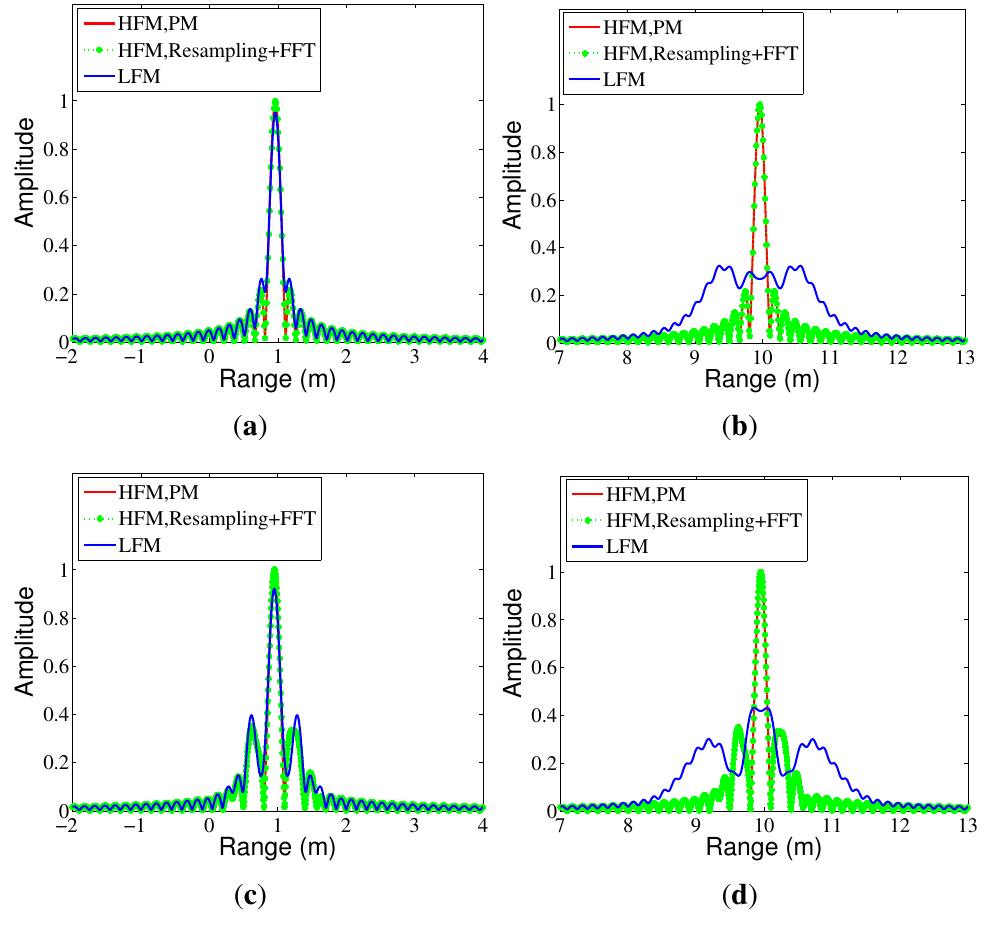
Figure 5. The high resolution range profile (HRRP) of a single point target. ( a ) Ideal waveform, υ = 100 m/s; ( b ) ideal waveform, υ = 1000 m/s; ( c ) with frequency errors, υ = 100 m/s; ( d ) with frequency errors, υ = 1000 m/s. Table 1. Peak sidelobe ratio (PSLR) and integrated sidelobe ratio (ISLR) with different velocities. Ideal Waveform With Frequency Errors Waveform Velocity (m/s) PSLR (dB) ISLR (dB) PSLR (dB) ISLR (dB)